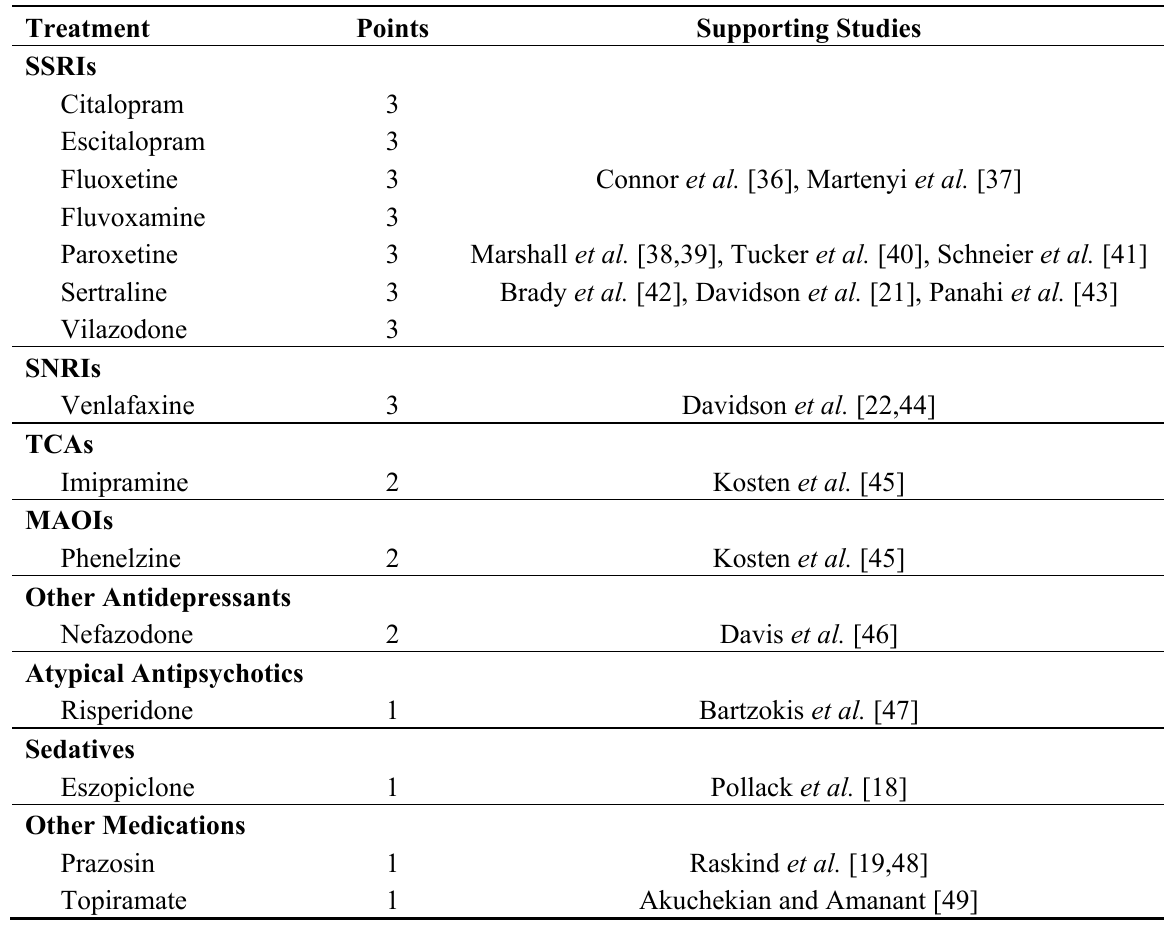
Table 2. Pharmacotherapy treatments scored by the E-TRIP.